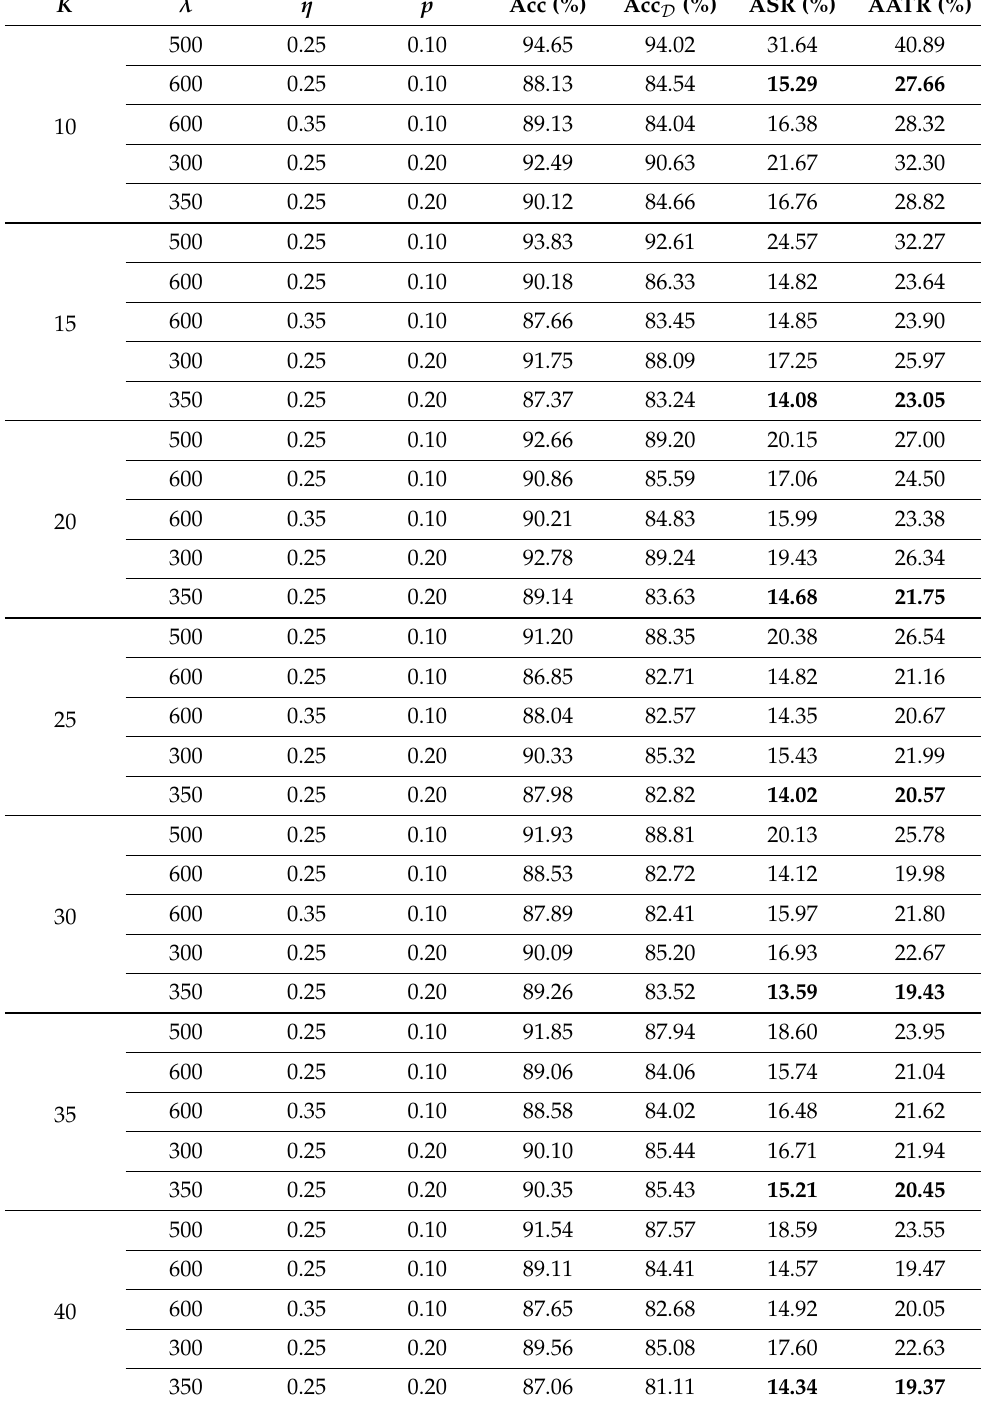
Table 4. Ablation study of different DMD parameters on MNIST. λ is the differentiation factor of the sub-federated model. η is the proportion of the sub-federated model. p is the probability of Bernoulli